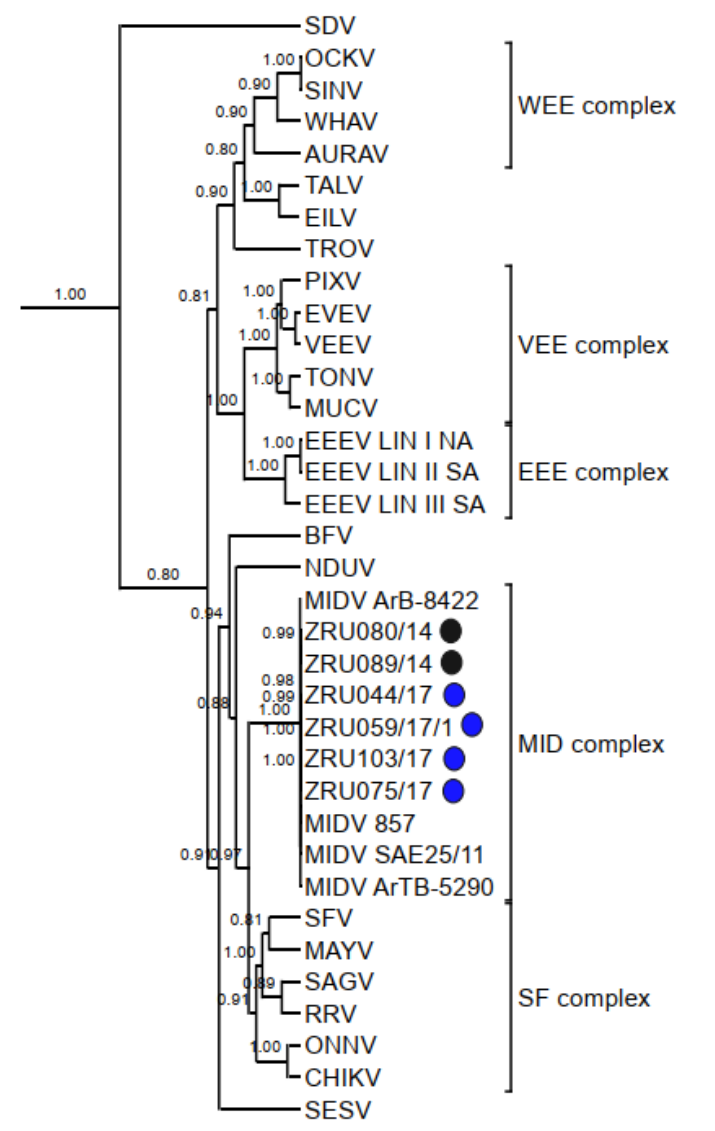
Figure 7. Rooted phylogenetic tree produced from Bayesian analysis using BEAST based on concatenated nucleotide sequences of non-structural (7236 base pairs) and structural protein (3777 base pairs) open reading frames (35 taxa, model GTR+G+I) of alphaviruses is shown. Probabilities >0.7 are shown on major branches. Sequences of horse Middelburg virus positives described in the current study are indicated with ZRU numbers and circle colours correspond to year sample was screened as follows: 2014 indicated in black (sequences obtained from whole blood samples) and 2017 indicated in blue (sequences obtained from culture isolates). Alphavirus complexes are indicated by brackets. The tree is drawn to scale representing the number of nucleotide substitutions per site. AURAV: Aura virus; BF: Barmah Forest virus; CHIKV: Chikungunya virus; EILV: Eilat virus; EEEV: Eastern equine encephalitis virus; EVEV: Everglades virus; GETV: Getah virus; MAYV: Mayaro virus; MIDV, Middelburg virus; MUCV: Mucambo virus; NDUV: Ndumu virus; OCKV: Ockelbo virus; PIXV: Pixuna virus; RRV: Ross river virus; SDV: Sleeping disease virus; SEV: Southern elephant seal virus; SFV, Semliki Forest virus; SINV: Sindbis virus; TALV: Taï Forest alphavirus; TONV: Tonate virus; TROV: Trocara virus; VEEV: Venezuelan equine encephalitis virus; WHAV: Whataroa virus; WEE: Western equine encephalitis.